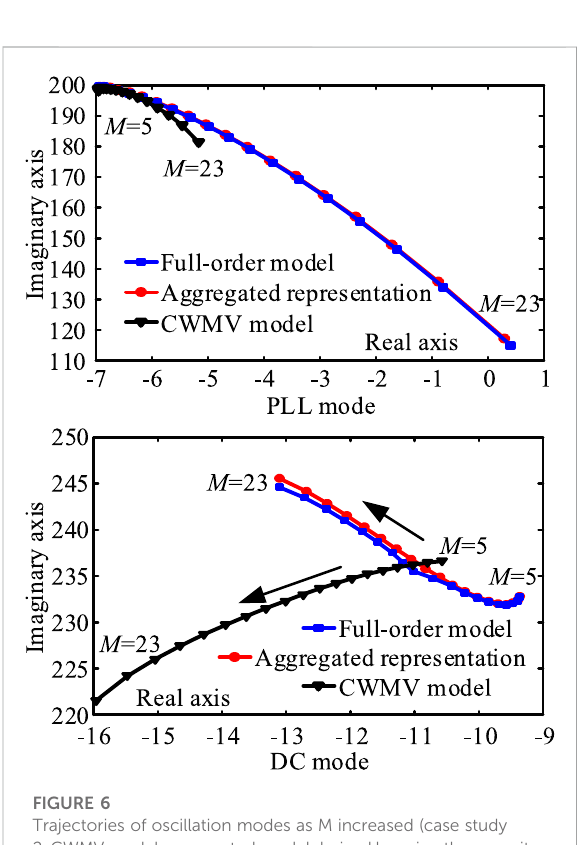
FIGURE 6 Trajectories of oscillation modes as M increased (case study 2, CWMV model, aggregated modelderived byusing thecapacity- weighted mean value